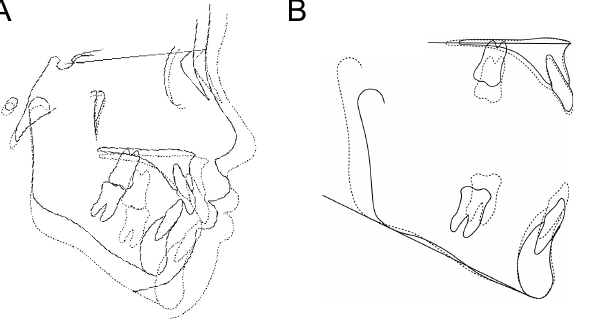
Figure 4. Superimposed images of Case 1; overall (SN plane, reference point S) ( A ); maxilla (palatal plane, reference point ANS) and mandible (mandibular marginal plane, reference point Me) ( B ).